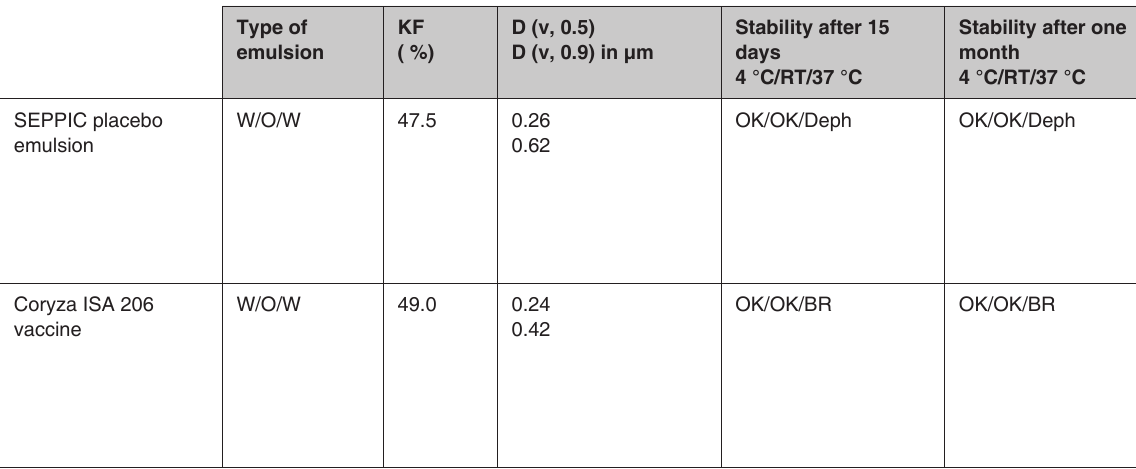
TABLE 1A Comparative evaluation of the Coryza special vaccine formulated with ISA 206 adjuvant, and a SEPPIC placebo emulsi- fied in the same adjuvant. Karl Fisher method (KF) defines the emulsion water content while D (v) is the mean of particles